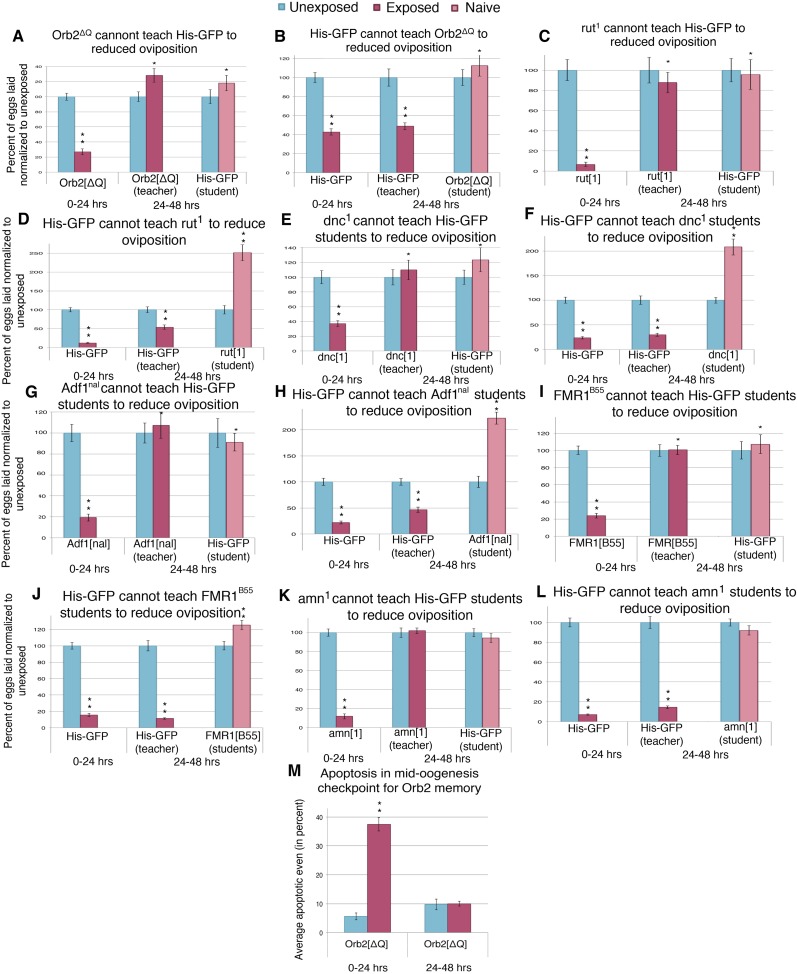
Learning mutants are unable to teach or be students.(A to L) Percent of eggs laid normalized to unexposed. (A to B) Orb2ΔQ as teacher and student. (C to D) rut1 as teacher and student. (E and F) dnc1 as teacher and student. (G and H) Adf1nal as teacher and student. (I and J) FMR1B55 as teacher and student. (K and L) amn1 as teacher and student. For (M), average percent of apoptotic events for stage 7/8 egg chambers. (M) Orb2ΔQ exposed and unexposed ovary apoptosis. Error bars represent standard error. (For [A] to [L] n = 24 biological replicates.) (For [M] n = 3 biological replicates from which 12 ovaries were scored for each group) (*p < 0.05, **p < 1.0e-5).